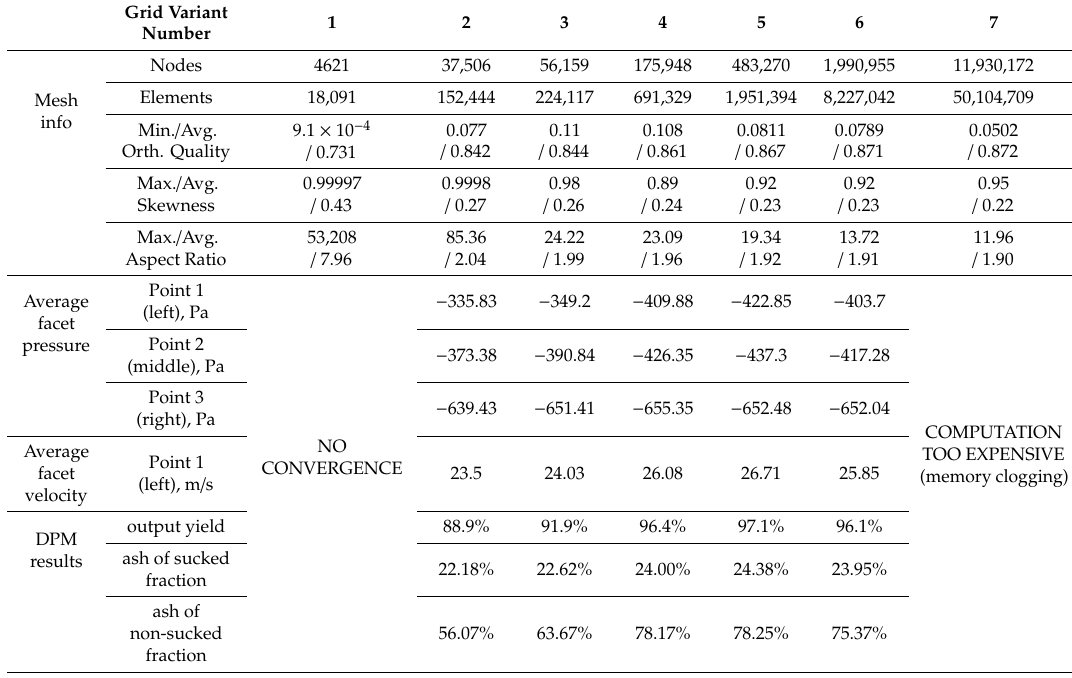
Table 2. Results of the grid-independence